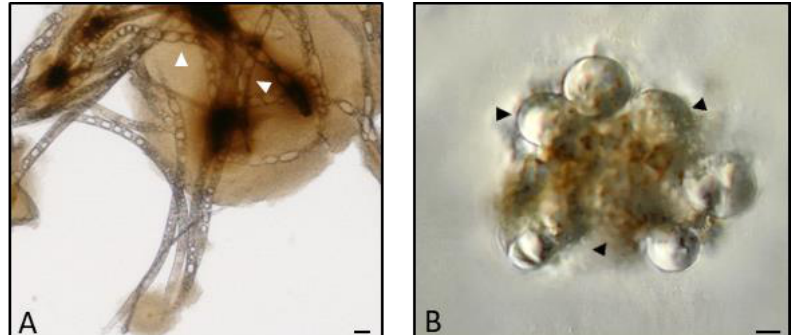
Figure 6. ( A ): Free-living nematodes ( Panagrolaimus rigidus ) incubated with cell-free hemolymph, arrowheads indicate melanin-trapped worms. ( B ): Humoral encapsulation of synthetic microbeads. Bars = 50 µ m. (unpublished images by Brivio [86]).